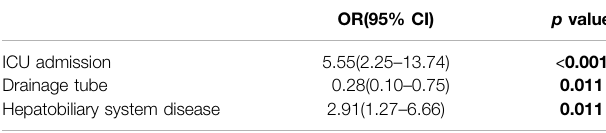
TABLE 4 | Logistic regression analysis of predictors factors for CPE.